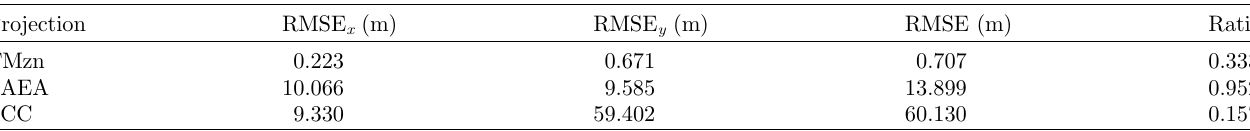
Figure 4. Distinctions between OAM Algarve (green) and NAM Algarve (blue) for LCC. Table 10. Root mean squared error.